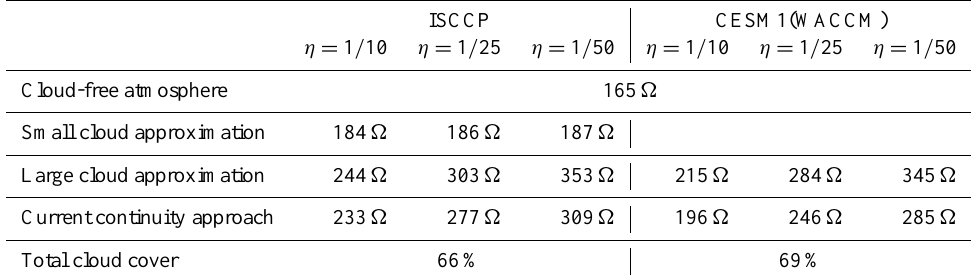
Table 1. Annual mean GEC global resistances.